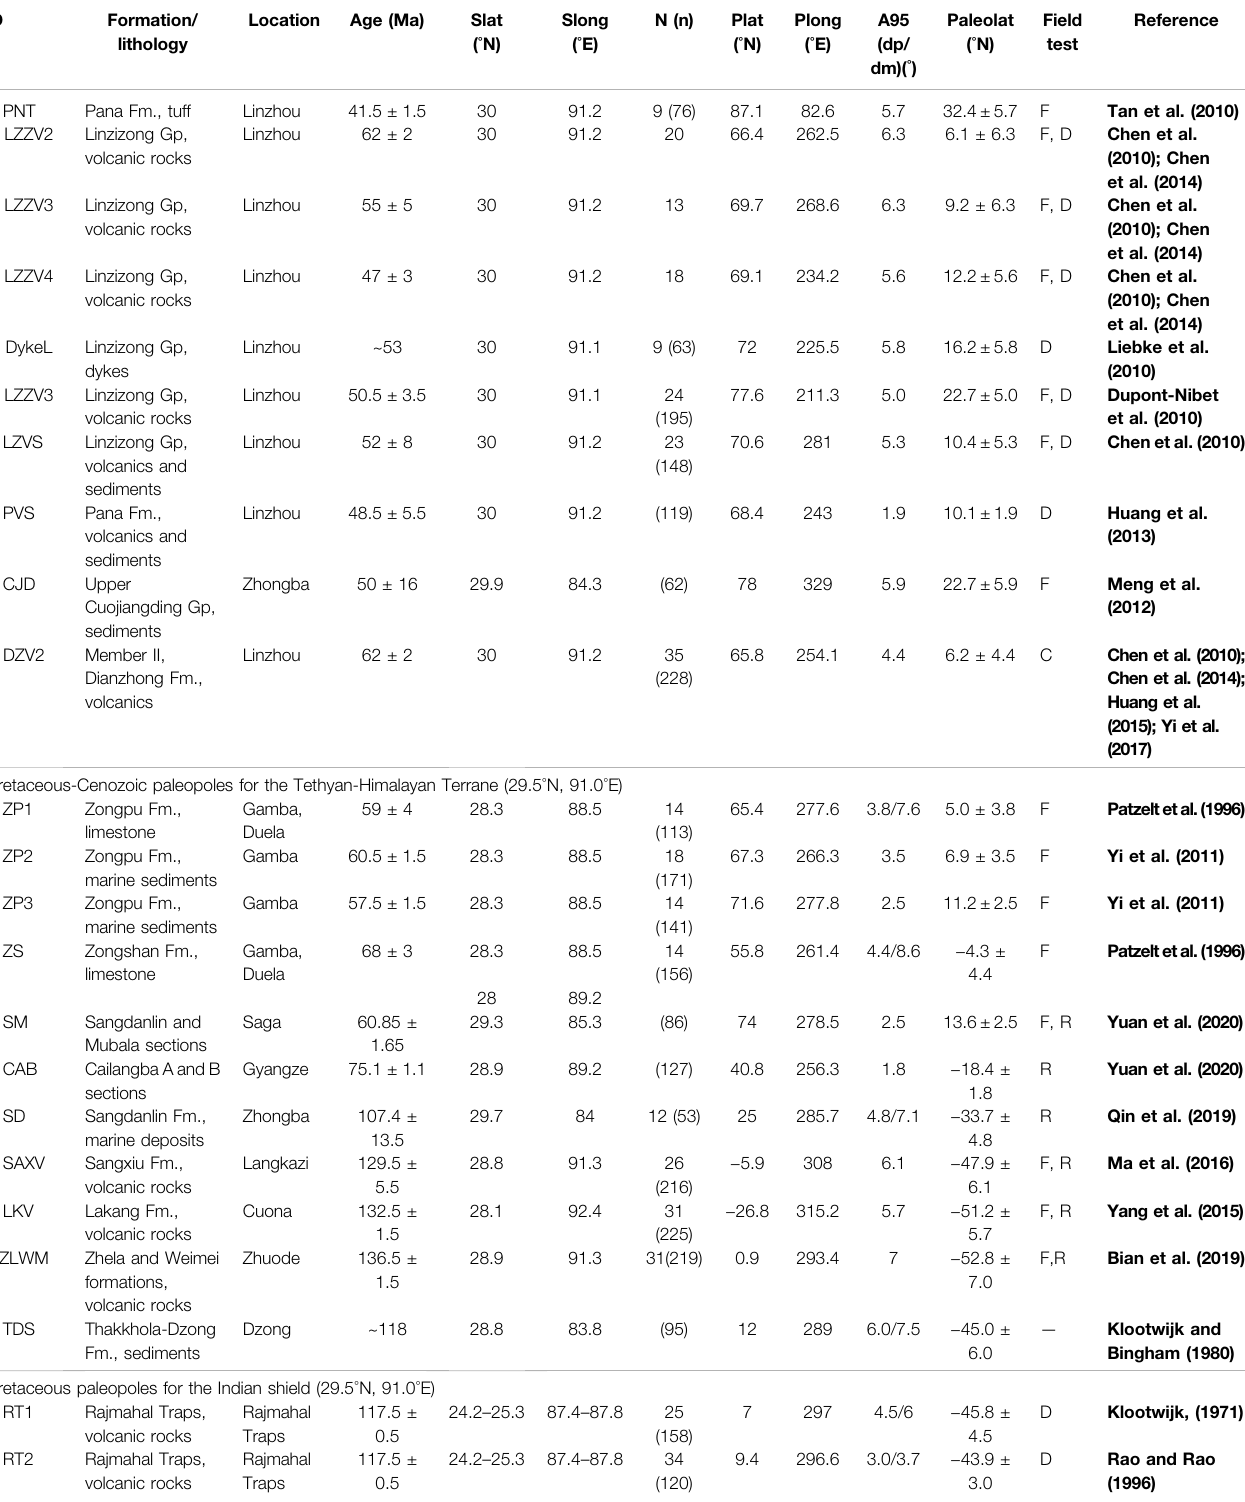
TABLE 2 | ( Continued ) Summary of Cretaceous and Early Cenozoic paleomagnetic poles from the Lhasa and Tethyan-Himalayan (two are from interior of Indian craton) terranes.